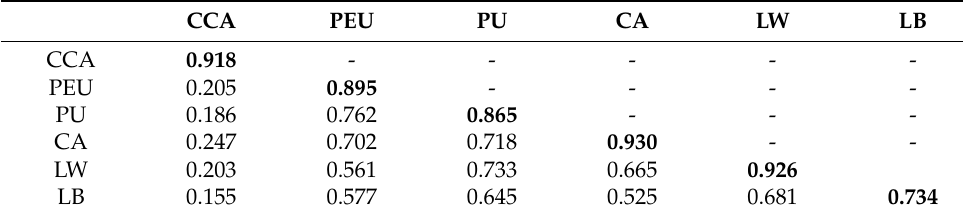
Table 4. Differential validity test.